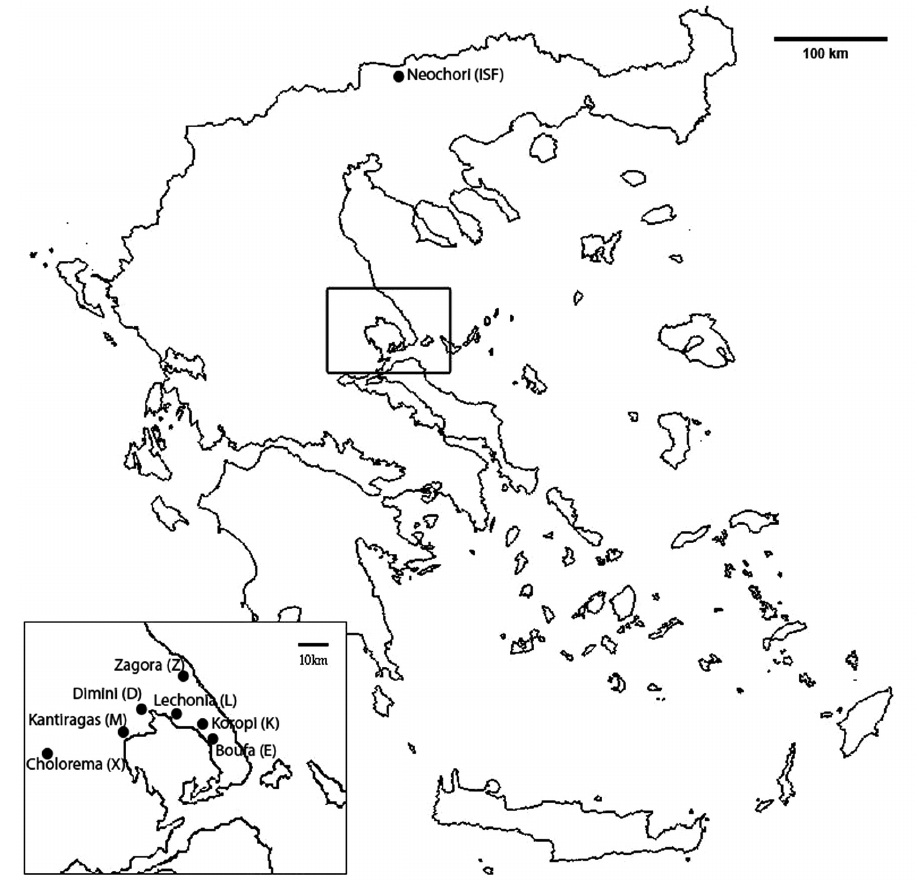
Figure 2. Map showing the sites where pear leaves spotted by Septoria pyricola were